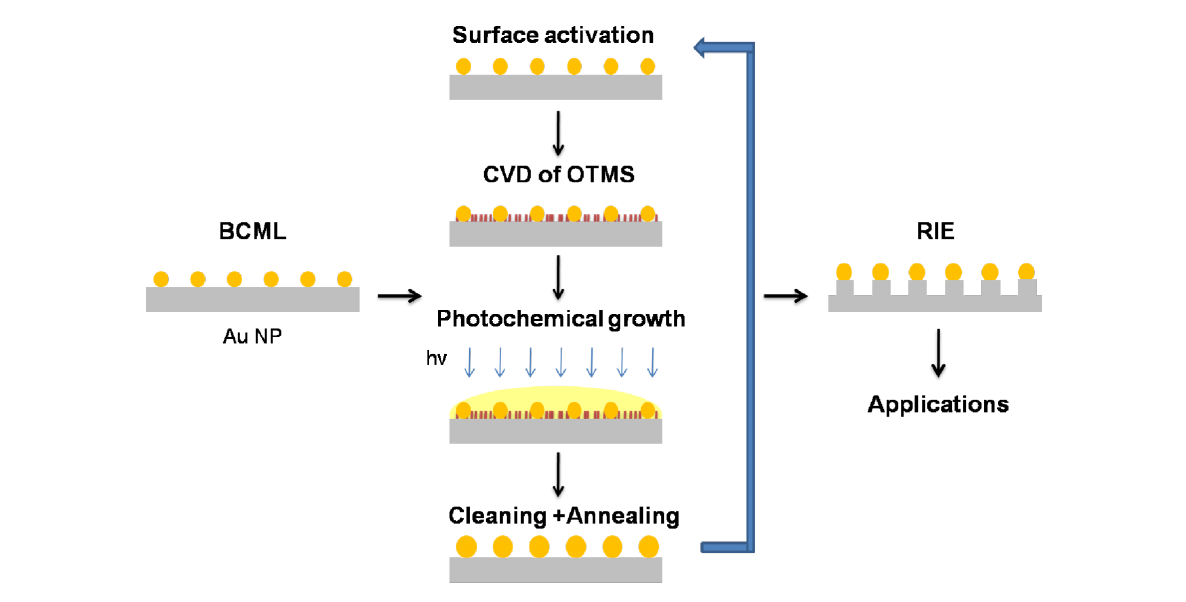
Figure 1: Schematics of nanopillar fabrication by applying Au NP as masks after fine tuning their size by an UV-light activated photochemical process. To stabilize the NP positions during the growth process, an OTMS layer is deposited by CVD first. This layer selectively forms chemical bonds to the silica substrate while leaving the Au NP